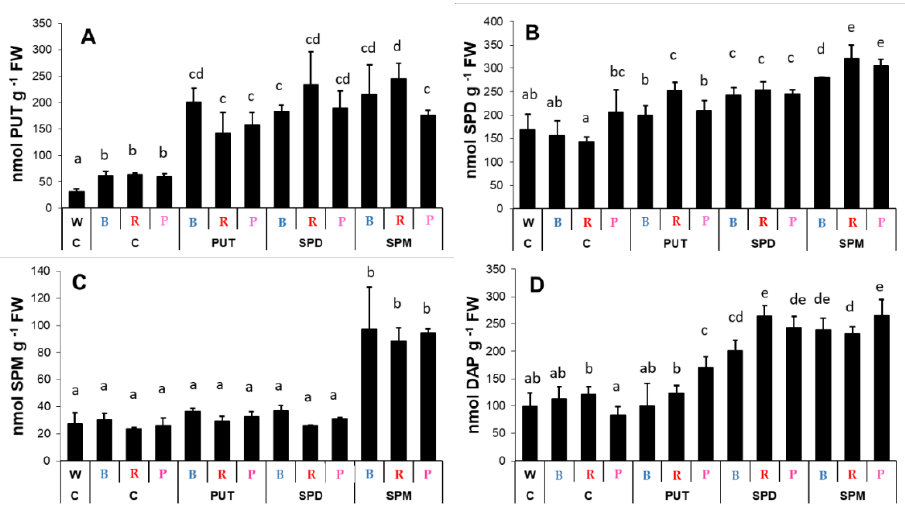
Figure 6. Polyamine contents (( A ): putrescine: PUT; ( B ): spermidine: SPD; ( C ): spermine: SPM; ( D ): 1,3-diaminopropane: DAP) in the roots of plants grown under different light regimes (white light: W, blue light: B, red + far-red: R and the combination of blue and red + far-red, pink: P) treated with or without polyamines (control: C, putrescine: PUT, spermidine: SPD and spermine: SPM). Values are means ± SD ( n = 3). Different letters indicate statistically significant differences at p < 0.05 level, using Duncan’s post hoc test.